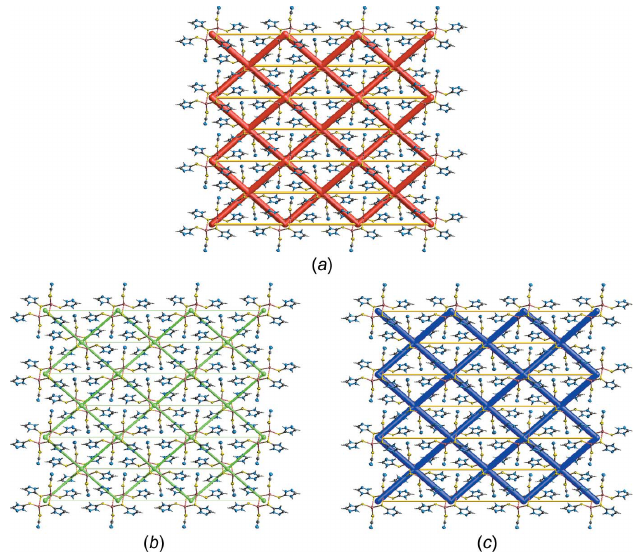
Figure 6 The colour interaction mapping and energy frameworks for (I) showing the ( a ) electrostatic potential force, ( b ) dispersion force and ( c ) total energy diagrams. All cylindrical radii were adjusted to the same scale factor of 100 with a cut-off value of (cid:4) 50.0 kJ mol (cid:4) 1 within a 3 (cid:6) 3 (cid:6) 3 unit cell and their sizes are proportional to the relative strength of the corresponding